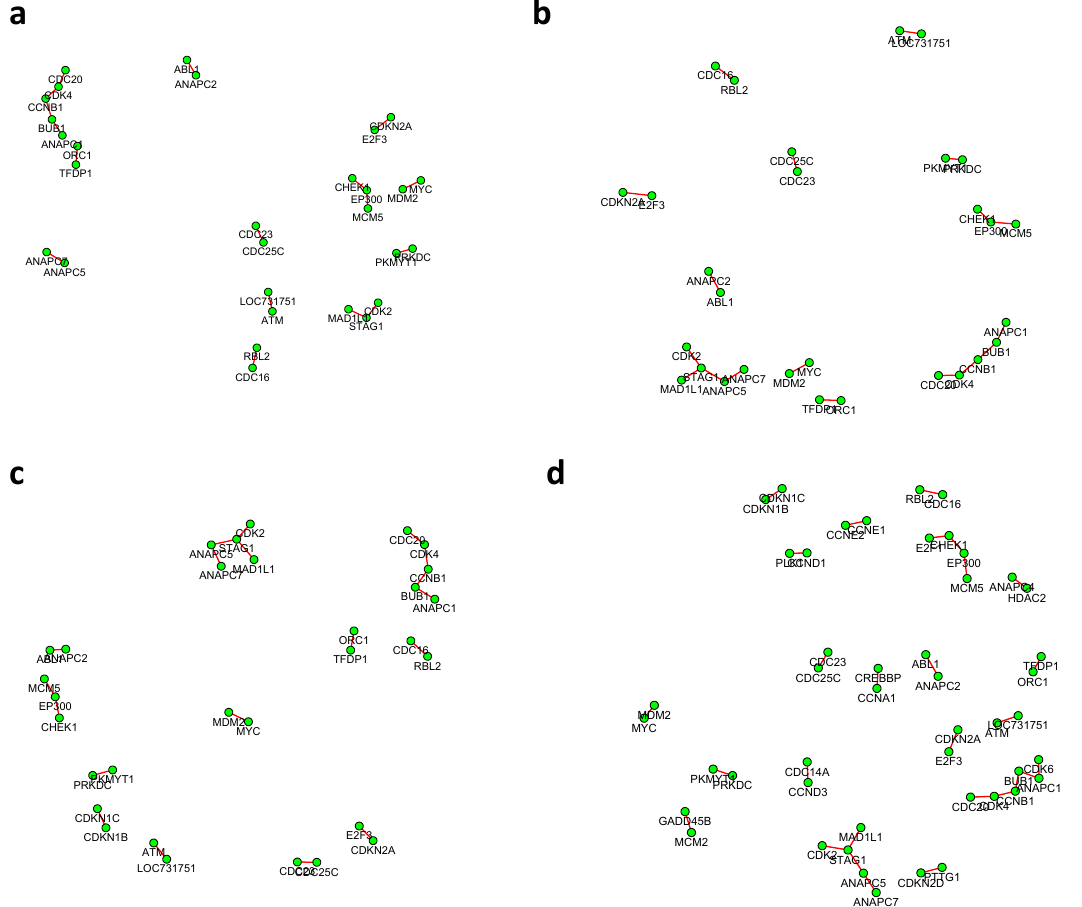
Figure 6. The inferred differential networks between the LumA and Basal-like subtypes under different desired FDR levels: ( a ) 0.05; ( b ) 0.10; ( c ) 0.15; ( d ) 0.20, with all isolated genes being removed. Each connection in the network represents an identified differential edge.